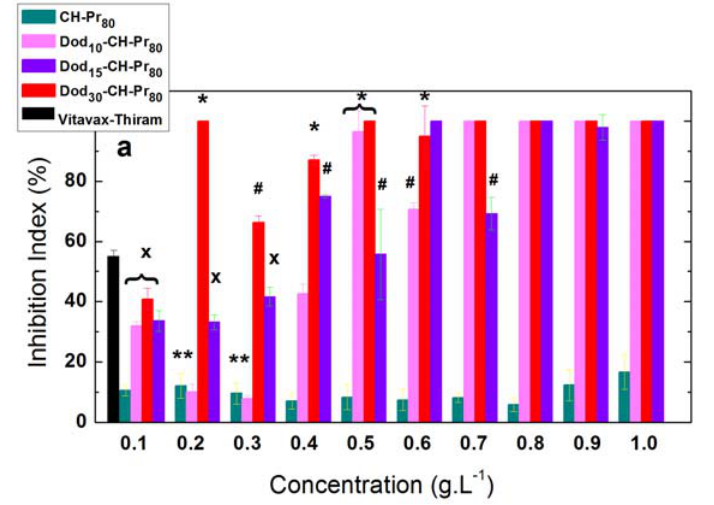
Figure 4. Effect of the hydrophobic modification of the quaternary derivatives of chitosan on the mycelial fungal growth of ( a ) A. Flavus and ( b ) A. parasiticus . Black bar corresponds to Vitavax  -Thiram at 0.1 g.L − 1 of the crude product. Vertical bars within the same concentration with different symbols are significantly different according to Kruskal- Wallis test ( p <